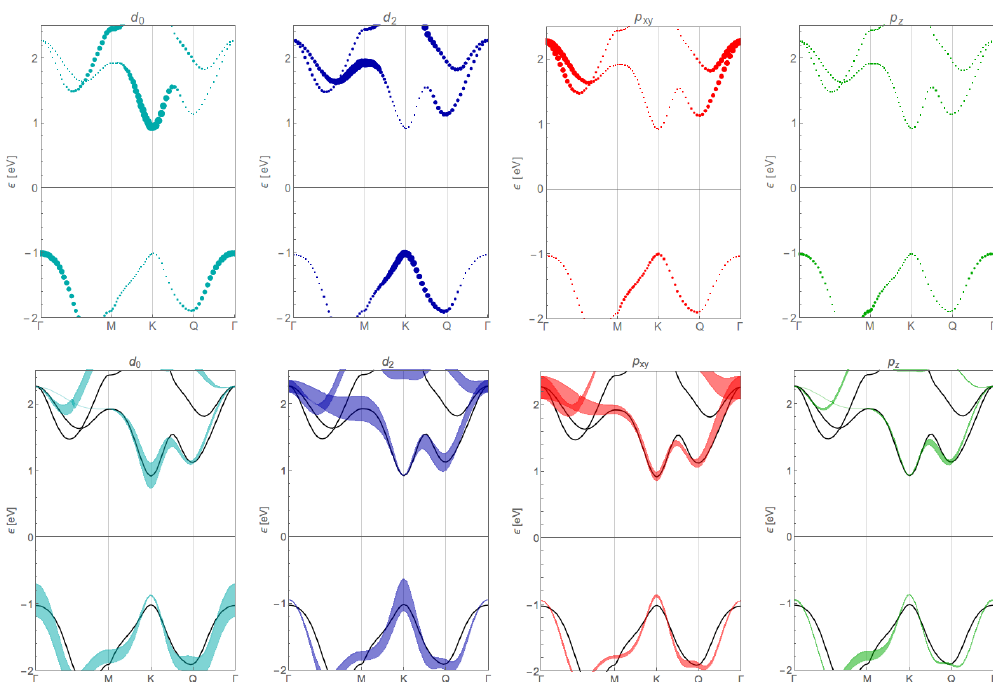
Figure B2. Same as Figure 4 but for WS 2